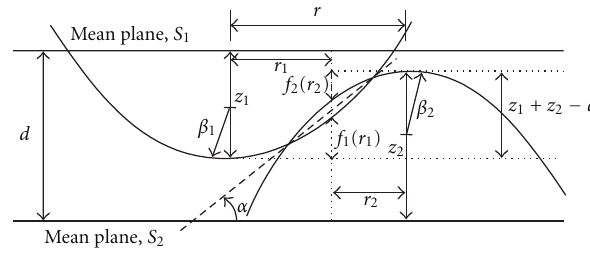
Figure 2: Asperity contact.